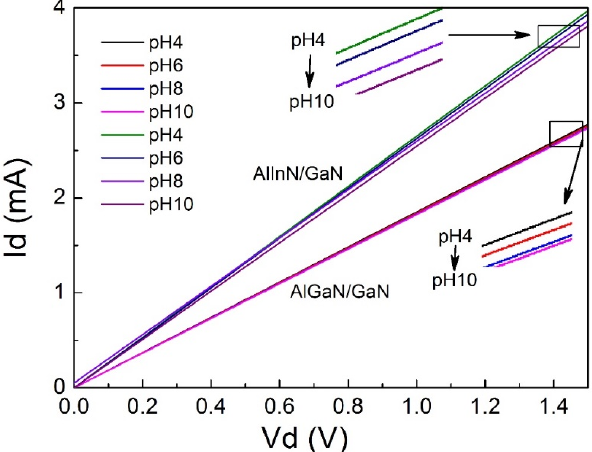
Figure 3. The I d - V d performance of two kinds of gateless HEMT structure sensors; they are AlInN/GaN and AlGaN/GaN heterostructures, respectively.